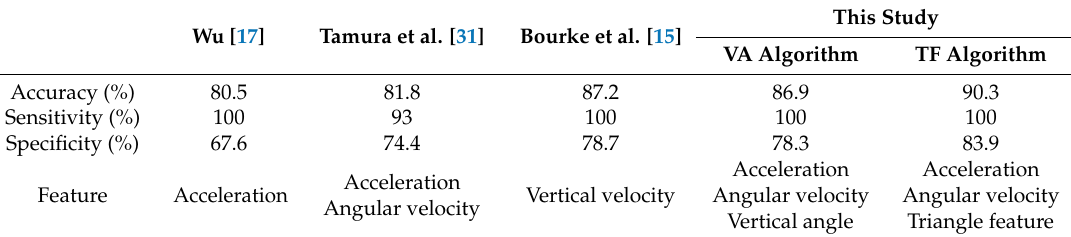
Table 6. Accuracy comparison with previous